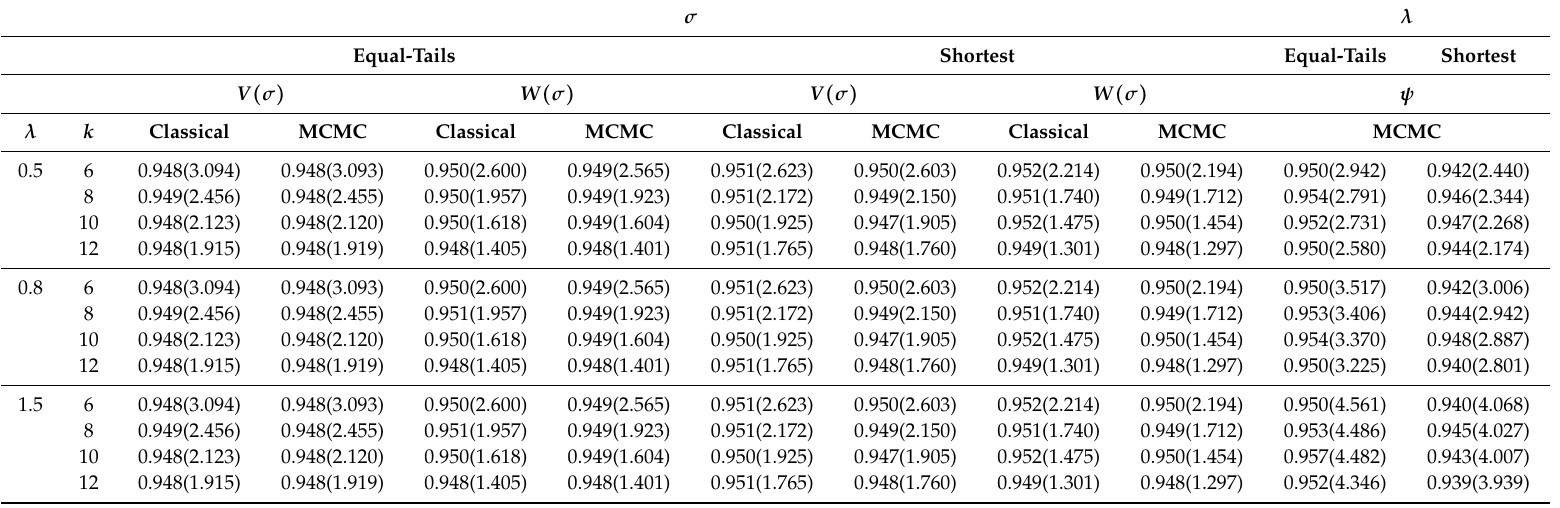
Table 1. Coverage probabilities (CPs) (average lengths (ALs)) of CIs for σ and λ